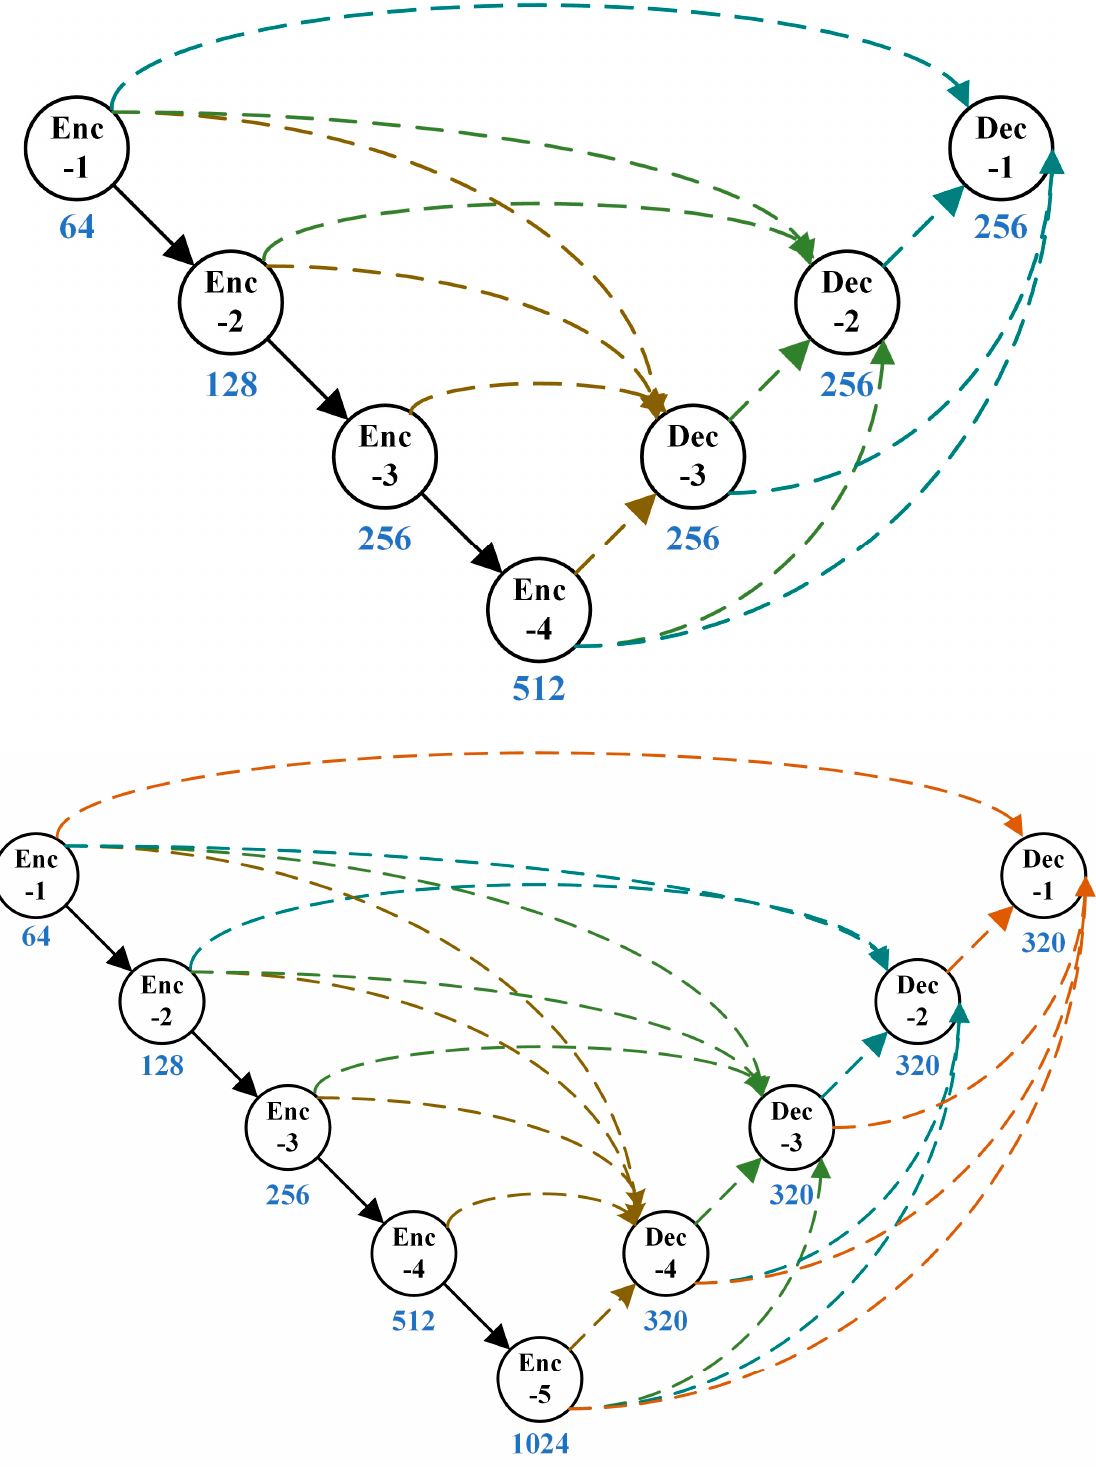
Figure 10. Architecture diagram of Polar-Unet3+ and MS-Polar-Unet3+. The difference was that an encoder and decoder were added.